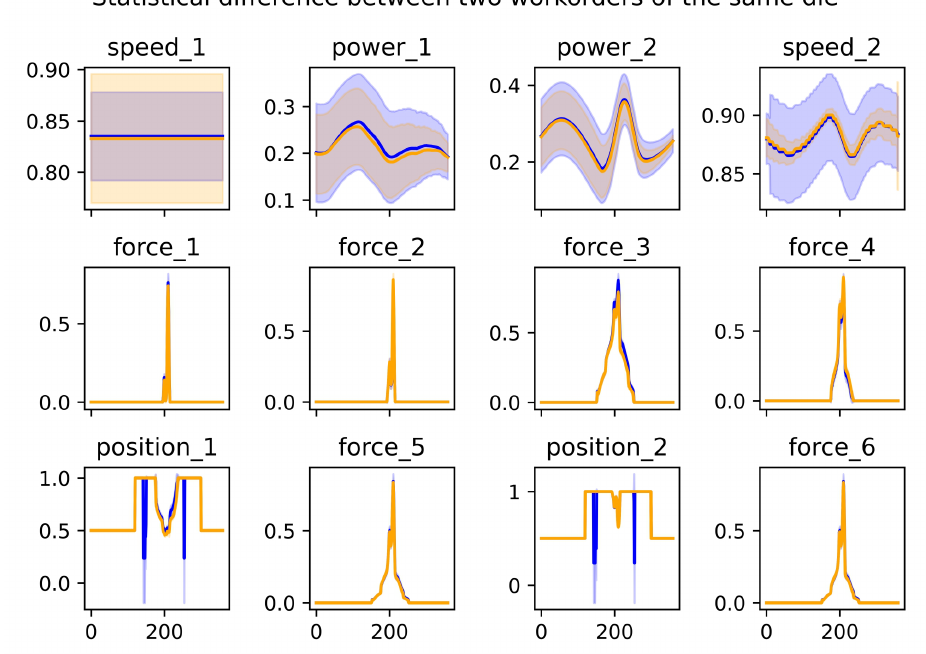
Figure 9. Statistical distribution of two continuous workorders’ stroke variables with a time difference of 7 days, represented by blue and orange colors. The average sensor signal or a workorder is represented by a continuous line, and its standard deviation is represented by a semi-transparent envelope range of that signal’s